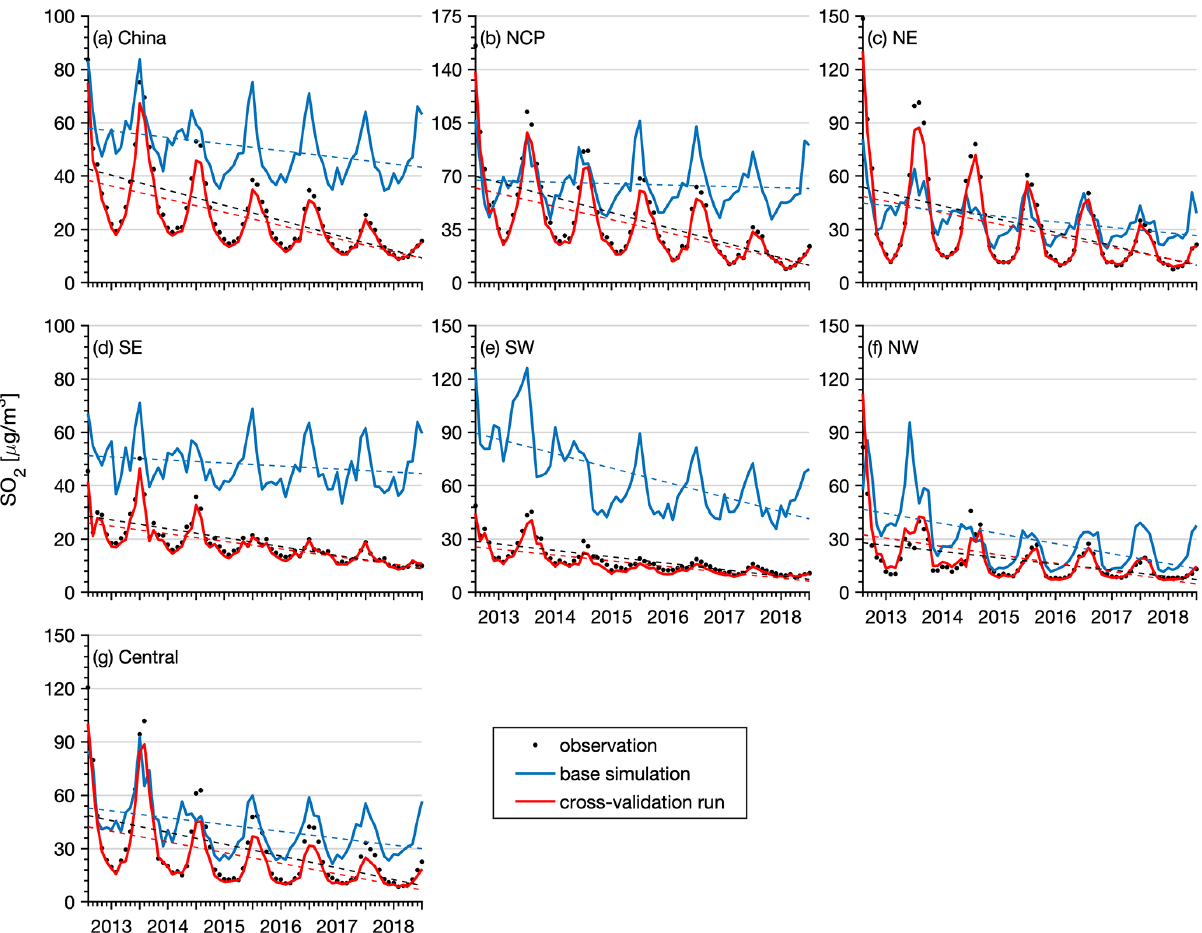
Figure 11. Same as Fig. 7 but for the SO 2